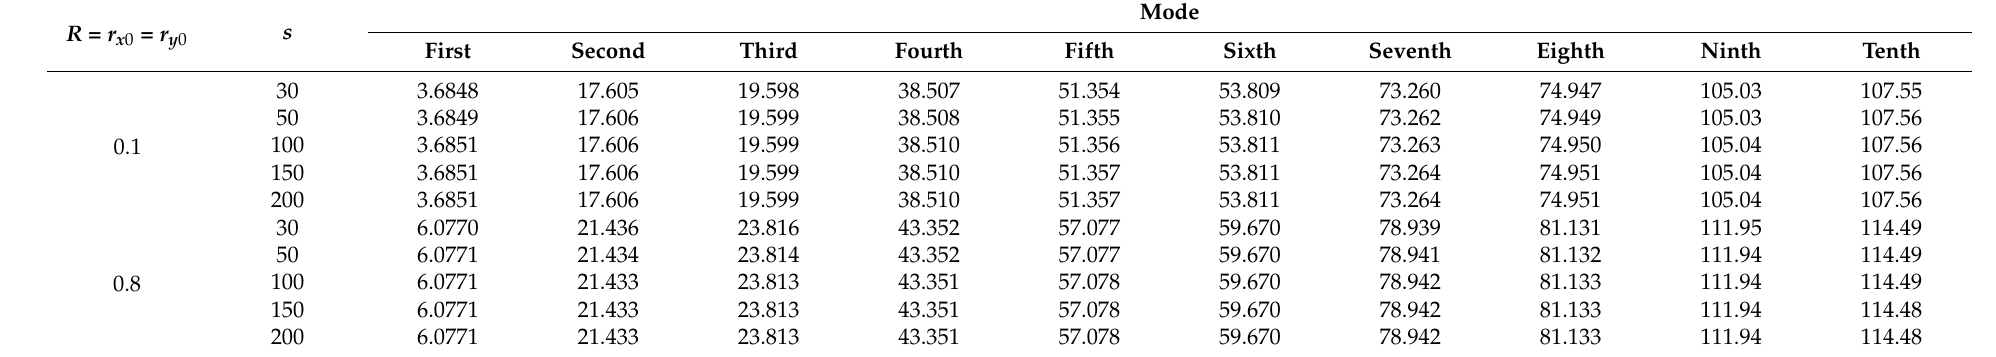
Table 10. Convergence of the dimensionless frequency parameter φ for the RRFF square plates with r = r x 0 = r y 0 equaling 0.1 and 0.8, respectively.